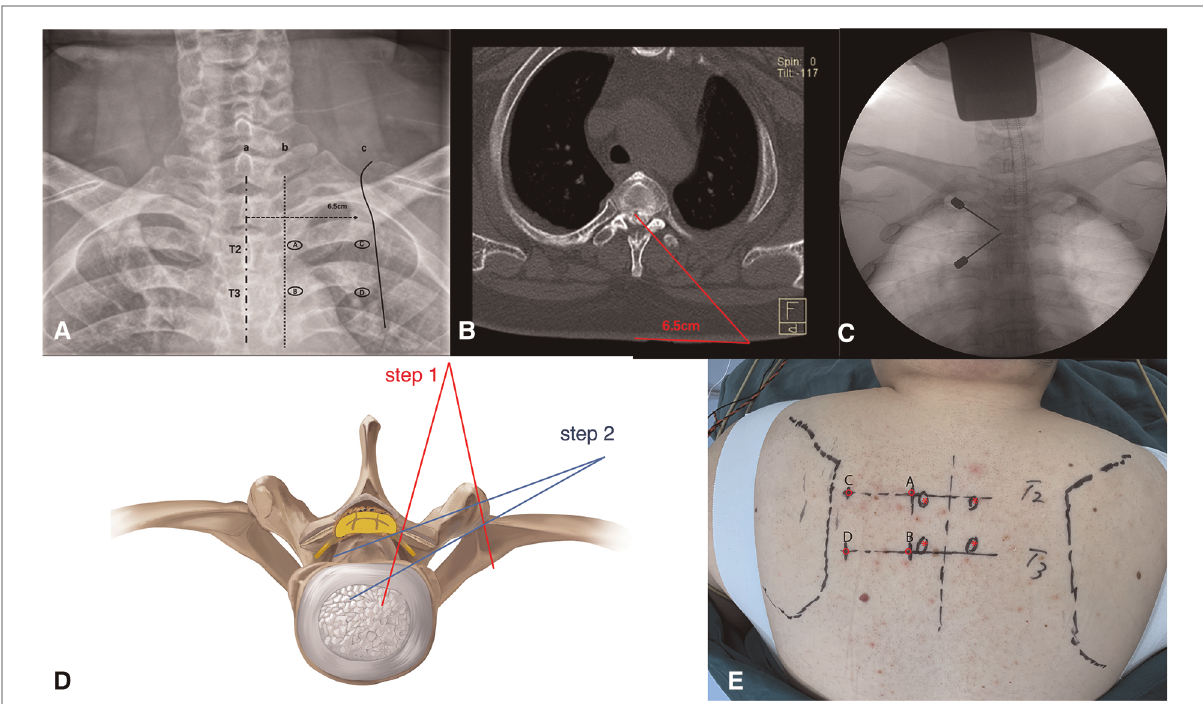
FIGURE 2 ( A,E ) The localization of the portals on the preoperative anteroposterior radiograph and the body surface. ( B,D ) Preoperative assessment of the extent of spinal cord decompression. ( C ) Puncture at portals A and B, and the target is the left T2 – T3 facet